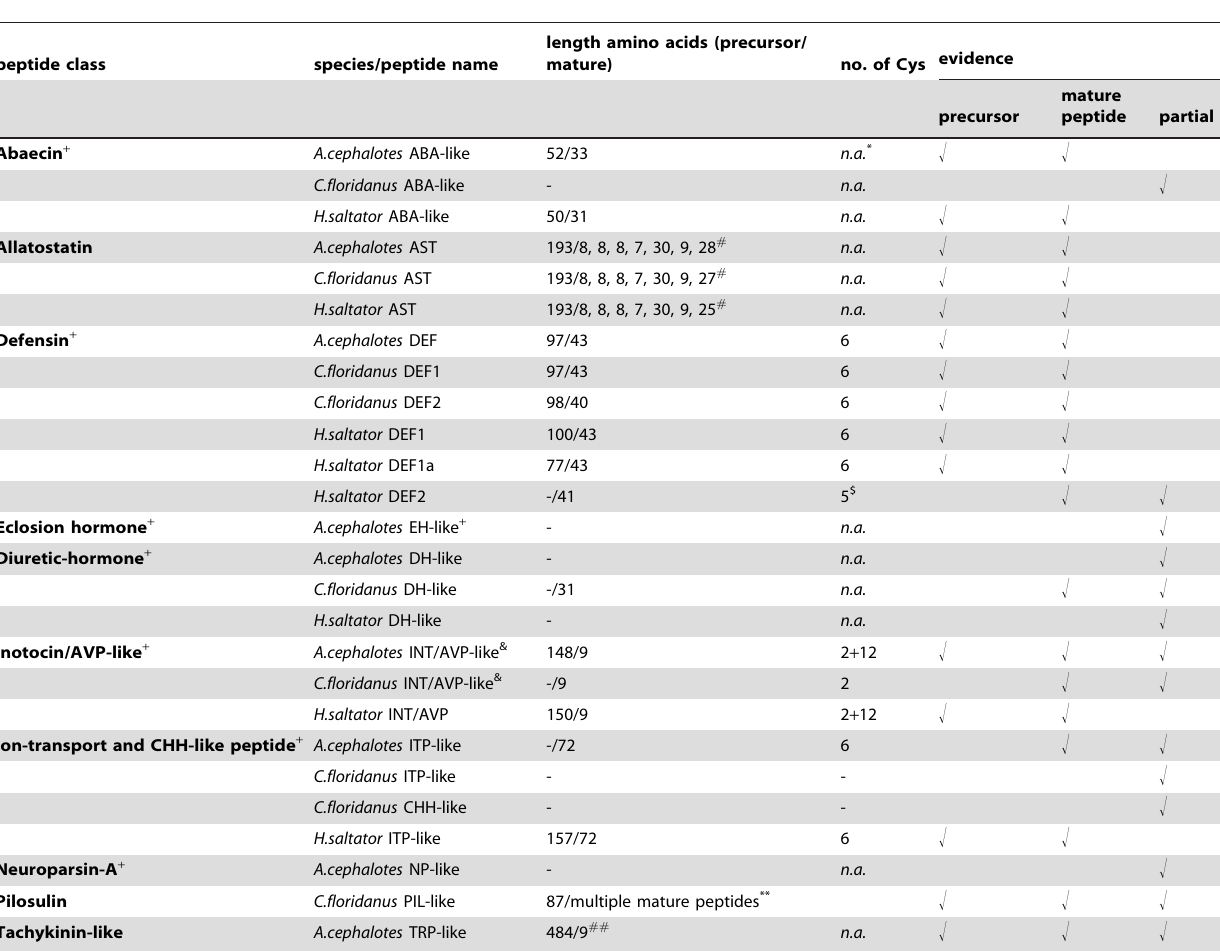
Table 1. Selected defense- and neuropeptides from ant species characterized by genome-mining.